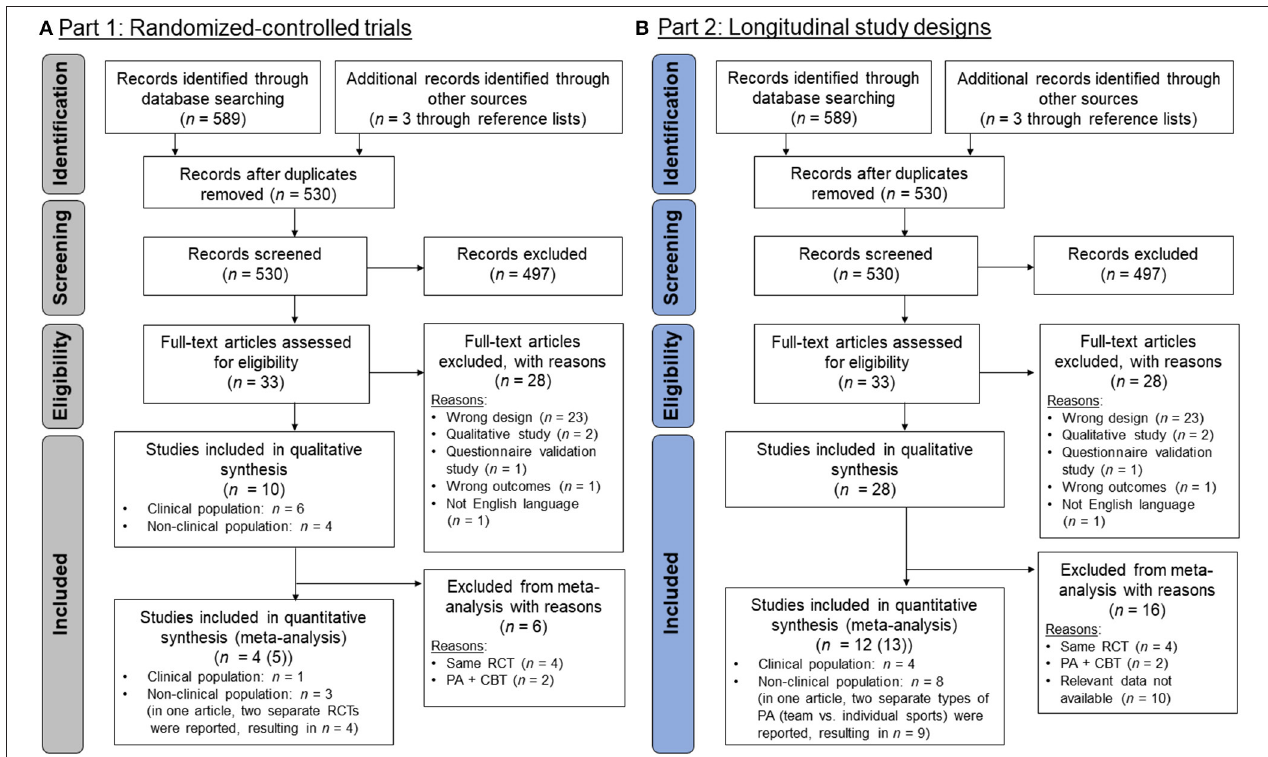
FIGURE 1 | PRISMA flow-chart diagrams (Moher et al., 2009): (A) Studies with a randomized-controlled trial (RCT) design (part 1); (B) studies with a longitudinal design (part 2). The RCTs that were found in (A) were also included in (B) . The steps until inclusion were the same part 1 and 2 until the screening process and, therefore, the numbers are